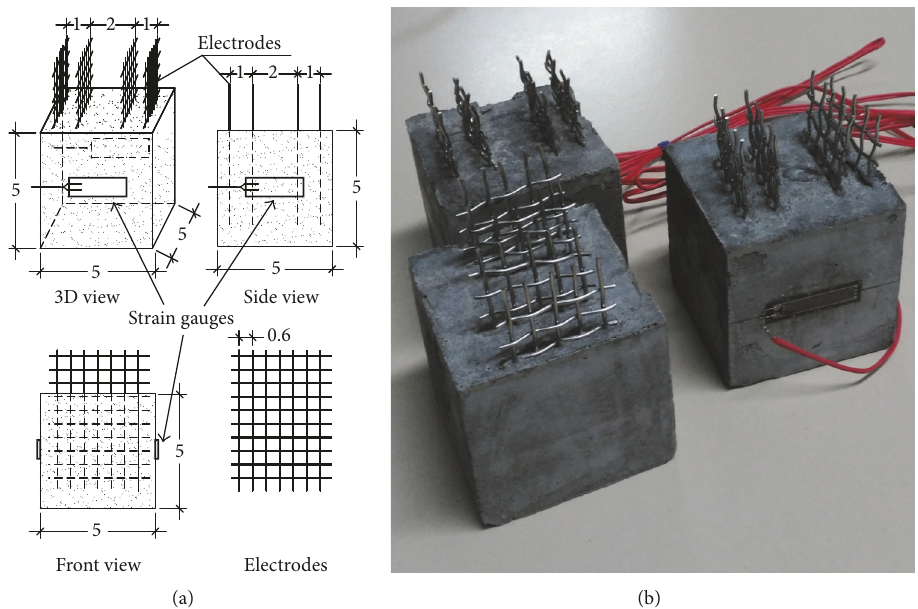
Figure 1: Geometry of the samples and electrodes (dimension in cm) (a); picture of the fabricated samples with strain gauges installed onto lateral surfaces (b).